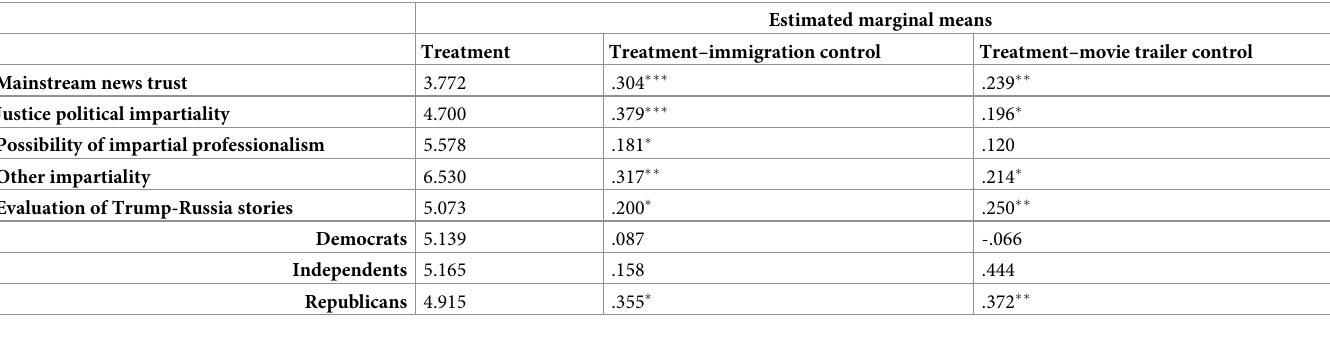
Table 2. Study 2 treatment mean